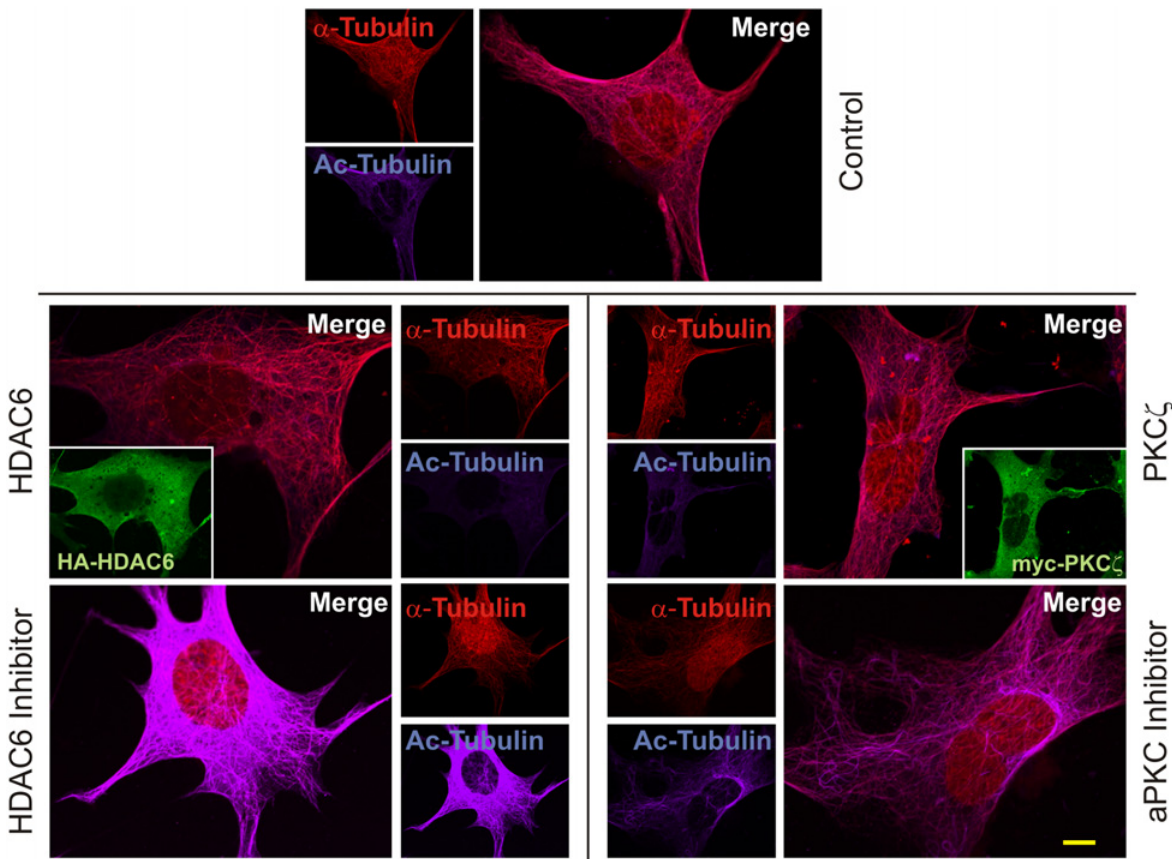
Fig 4. Atypical PKC ζ regulates HDAC6 deacetylase activity. Parental MEF cells were transfected to overexpress either HA-HDAC6 or myc-PKC ζ or were treated with HDAC6 inhibitor tubacin (10 μ M for 4 hours) or aPKC inhibitor (myristoylated pseudosubstrate — 20 μ M for 16 hours). Cells were subsequently fixed with 4% paraformaldehyde prior to immunofluorescence staining using α -tubulin antibodies (1:100) detected with Cy5 secondary antibody (1:400) and acetyl-tubulin antibody (1:100) detected with Texas Red secondary antibody (1:400). Texas Red labeled acetyl tubulin was pseudocolored to 400nm using Nikon NIS Elements AR software to visually separate it from Cy5. Inset panels for HA-HDAC6 and myc-PKC ζ (HA and myc antibodies used at 1:100) overexpression were detected with Oregon Green secondary antibody (1:400). Images from a minimum of 25 cells each were used for statistical analysis. Scale bar is 10 μ